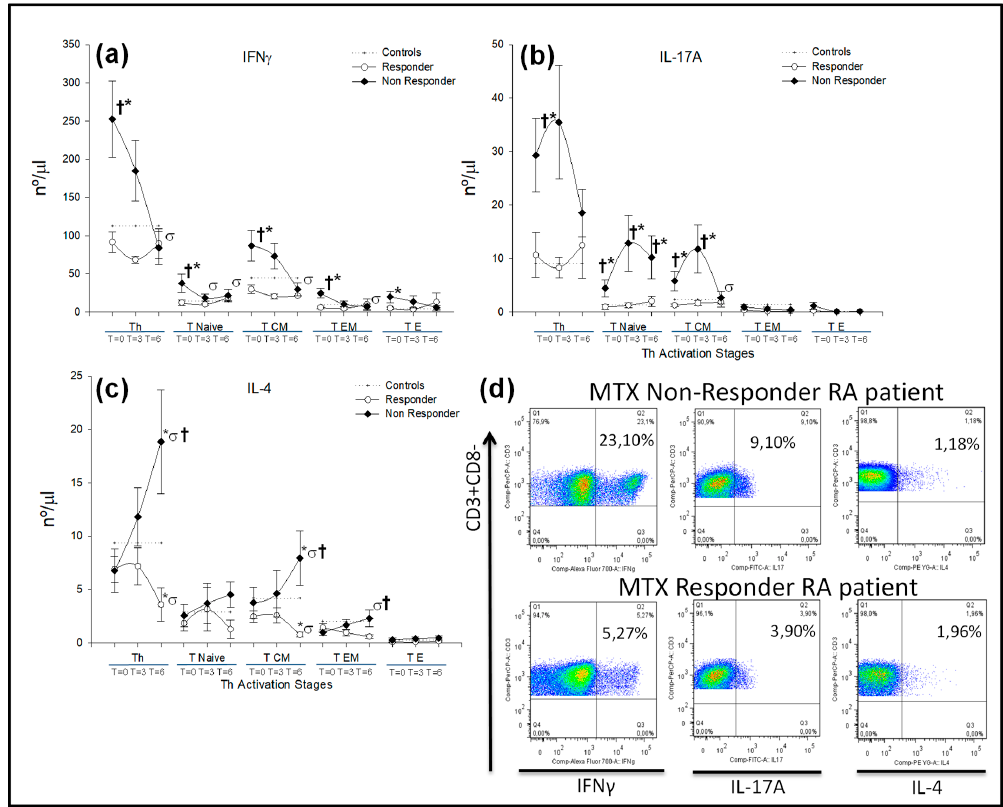
Figure 5. IFN γ , IL-4 and IL-17A-producing CD3 + CD4 + , T naïve , T CM , T EM and T E CD4 + T-lymphocyte